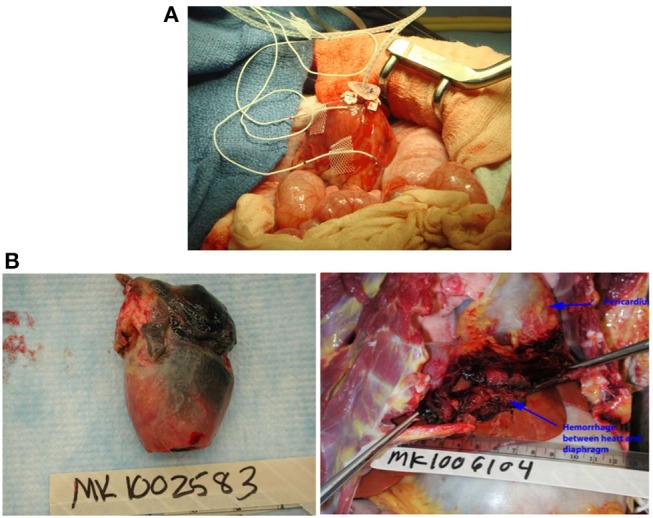
(A) Placement of left ventricular probe. A pursestring of pledgetted Prolene sutures is placed to secure the LV probe at the apex. (B) Complications of graft ischemia. Cardiac infarction (left) and rupture with intra-abdominal hemorrhage (right).